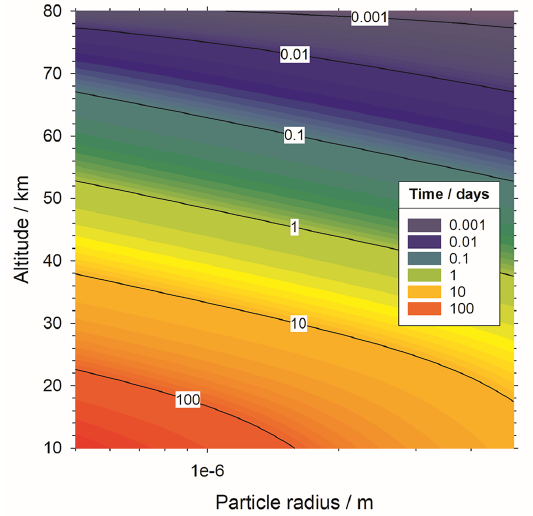
Figure 5. Cumulative time for a meteoric particle of given size to sediment gravitationally to a given